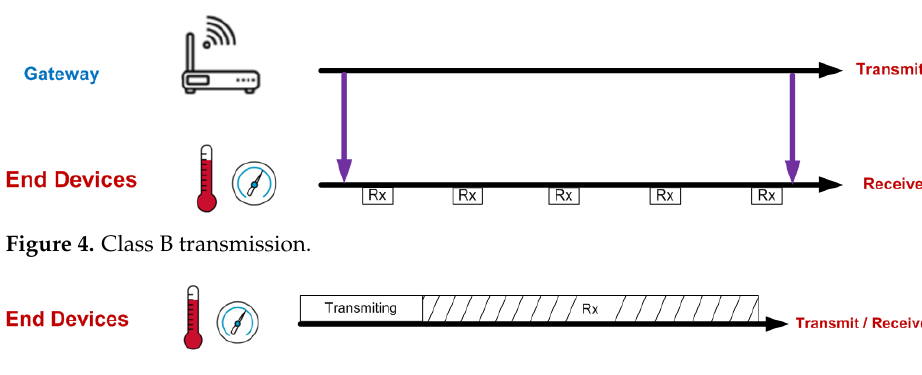
Figure 5. Class C transmission.